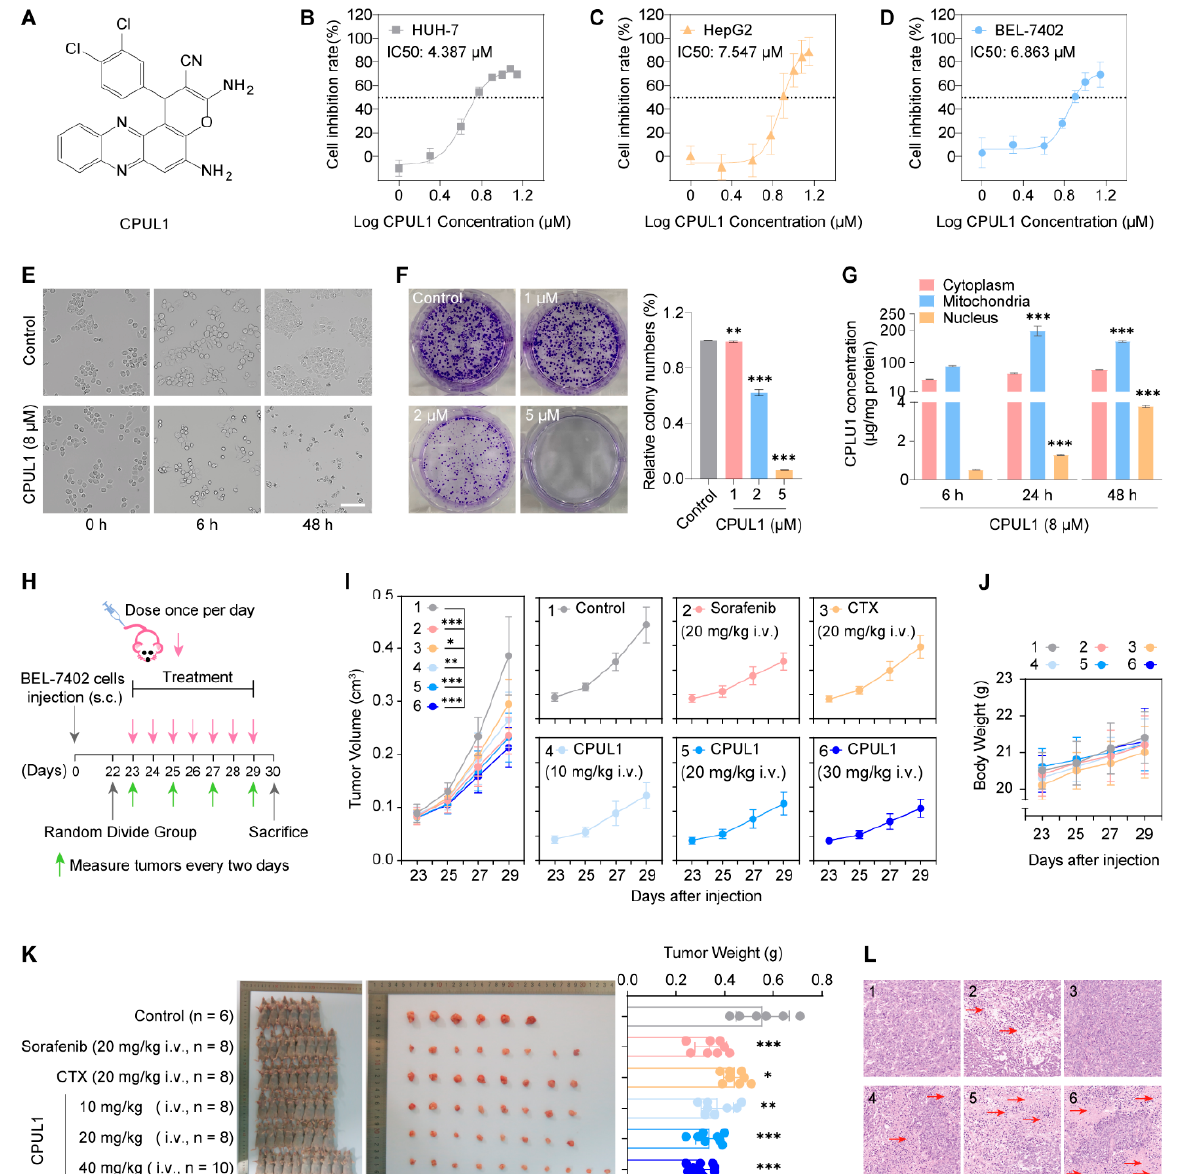
Figure 1. The structure of CPUL1 and the effects of CPUL1 on the viability of liver cancer cells in vitro and the antitumor effects in vivo. ( A ) The structure of CPUL1. ( B – D ) Liver cancer cell lines were treated with CPUL1 (0–14 μ M) for 48 h, and the CCK-8 assay measured cell viability. The absorbance was measured at 450 nm. ( E ) The cell morphology of BEL-7402 cells after 48 h of continuous treatment with CPUL1 (8 μ M), and the number of cells was significantly reduced. ( F ) The cells were treated with CPUL1 (8 μ M) for 14 days, and the cell colony formation assay determined the clone-forming ability. The histograms showed the quantified results of the colony formation assay. ( G ) The sub-organellar localizations of CPUL1 in the BEL-7402 cells. The concentration of CPUL1 in the mitochondria and nucleus at 24 h and 48 h was compared with the time point of 6 h, respectively. ( H ) Schematic of the animal model establishment, treatment, and measurement. ( I , J ) The tumor volume and body weight was measured every two days. ( K ) The xenograft tumors were separated when the animals were killed. The final tumor weights were measured. ( L ) Histopathological tests (hematoxylin and eosin staining) were performed on the BEL-7402 transplanted tumor tissues. Red arrows indicate necrotic areas. Scale bar = 50 µ m. The data were expressed as the mean ± SD; * p < 0.05, ** p < 0.01, *** p < 0.001. ns, not